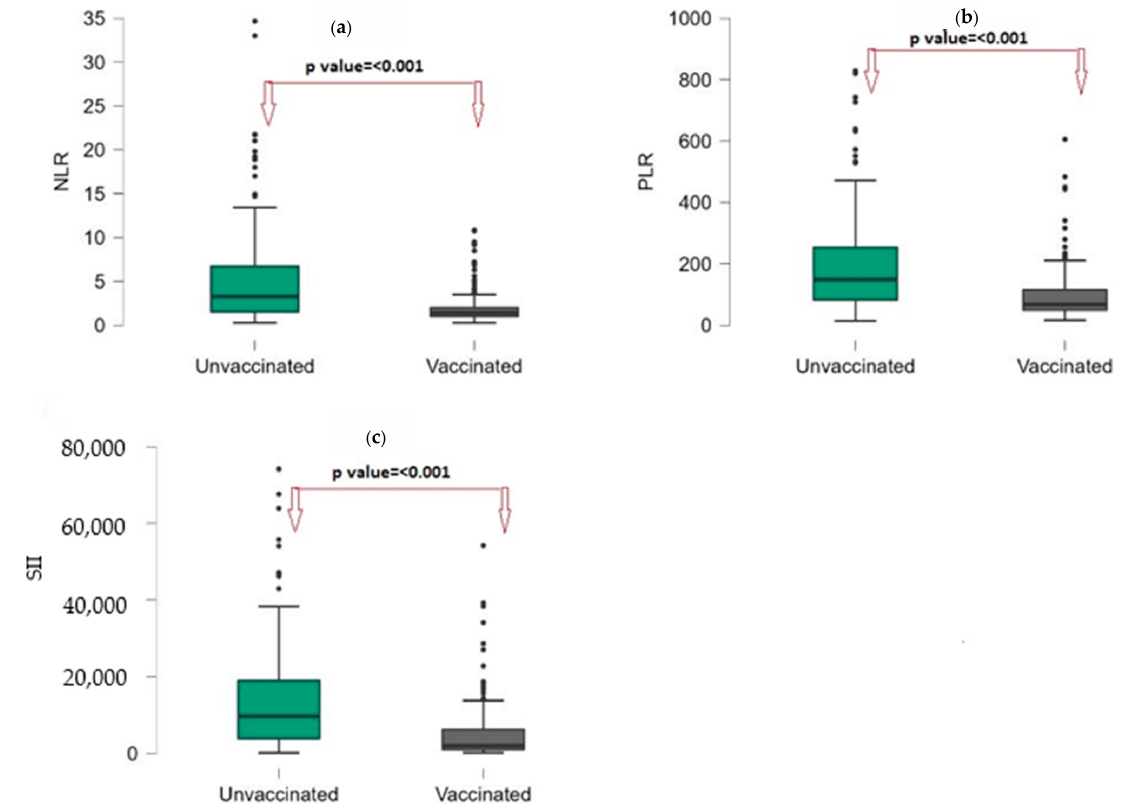
Figure 2. Box-plot graphs by vaccination groups, ( a ): NLR; ( b ): PLR; ( c ): SII. Points( • ) are represents the outliers. Table 3. Laboratory findings of breastfed and non-breastfed children with rotavirus